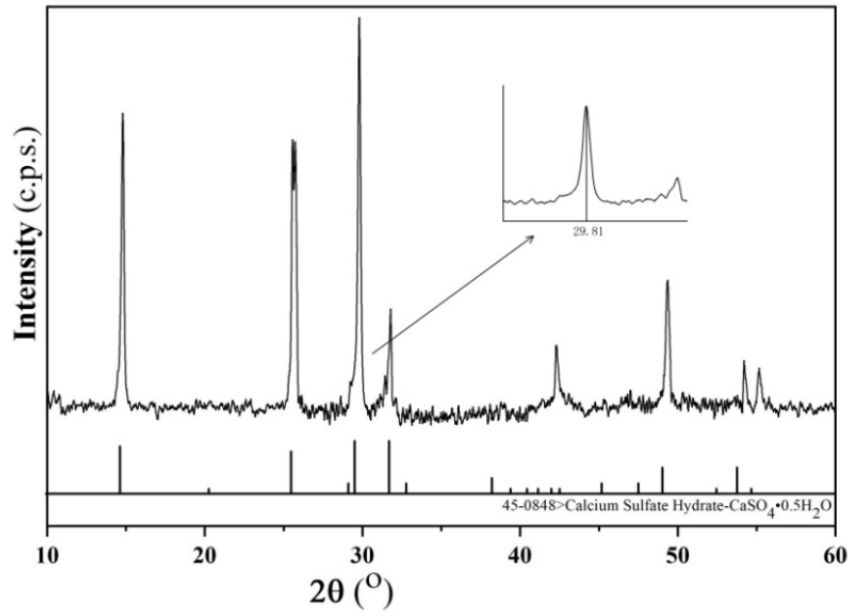
Figure 4. The XRD results of the CSH particles.